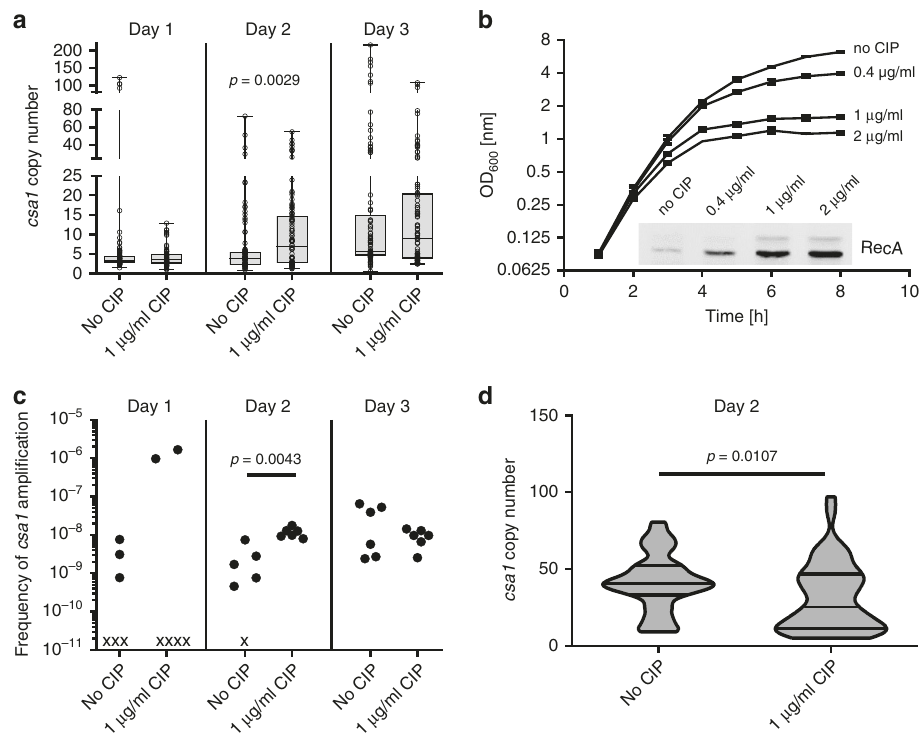
Fig. 2 Copy number diversi fi cation after in vitro evolution. a USA300 csa1::tetK was grown over three consecutive days in six parallel cultures in the presence or absence of cipro fl oxacin (CIP). Each day, the copy number of up to 16 clones of each culture showing high Tc resistance was screened by qPCR. Upper and lower box limits and the horizontal lines within the boxes represent 25 and 75% percentiles and the medians, respectively. The whiskers of the plots indicate minimum and maximum range. All data points are shown. Data are derived from six independent experiments and represent: Day 1, n = 96 and n = 73 of “ no Cip ” and “ 1 µ g/ml Cip ” , respectively; Day 2, n = 93 and n = 96 of “ no Cip ” and “ 1 µ g/ml Cip ” , respectively; Day 3, n = 93 and n = 96 of “ no Cip ” and “ 1 µ g/ml Cip ” , respectively. Datasets were not normal distributed (D ’ Agostino & Pearson omnibus test <0.0001) and statistical